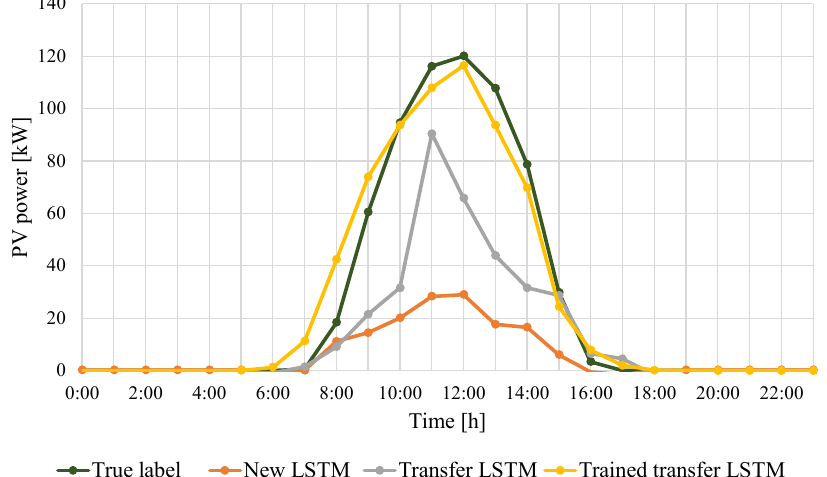
Figure 5. Day-ahead prediction of the PV power output of a random date in the test set for models based on the LSTM network.